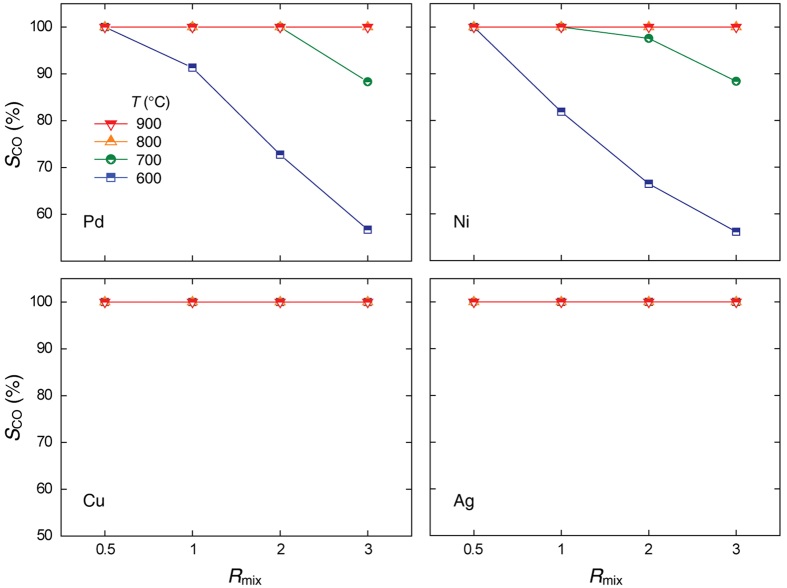
CO selectivity of each catalyst with respect to temperature and Rmix.The red, yellow, green, and blue lines correspond to temperatures of 900, 800, 700, and 600 °C, respectively. For reference, the Sco of the Al2O3 support in all cases is 100% in spite of its limited Xco2 performance.